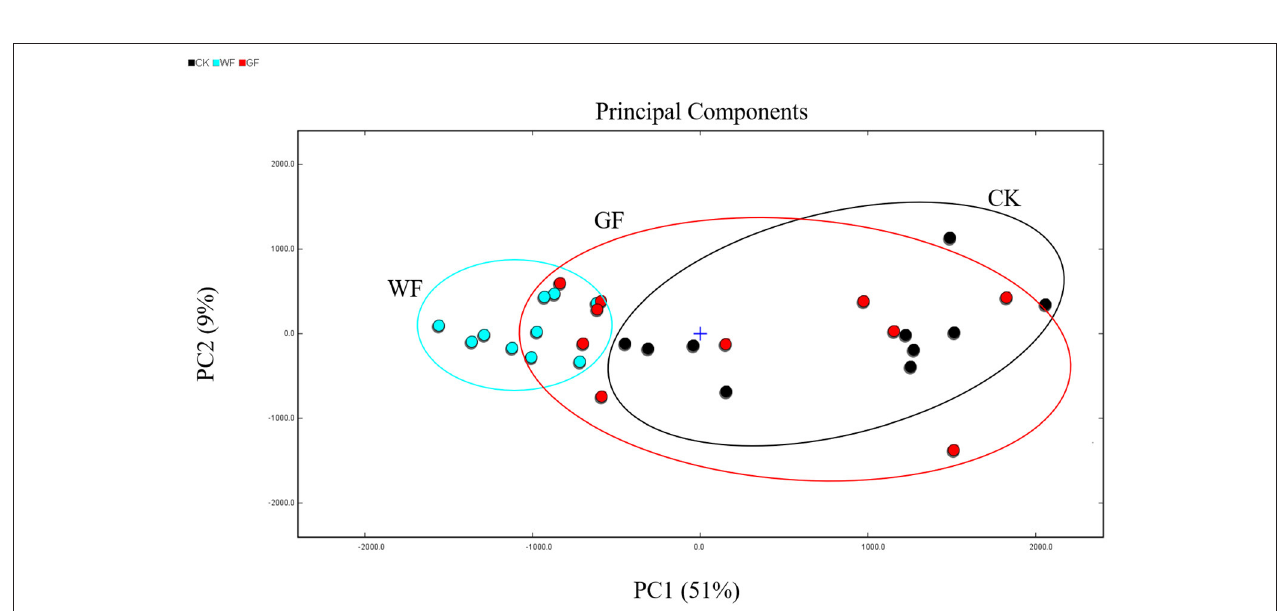
FIGURE 4 | PCA scores plot of raw milk from cows fed different diets. Black points: CK milk; blue point: WF milk; red point: GF milk. CK, basal diet (without flaxseed); WF, whole flaxseed (dairy cows were fed WF: 1,500 g/d per cow); GF, ground flaxseed (dairy cows were fed GF: 1,500 g/d per cow).